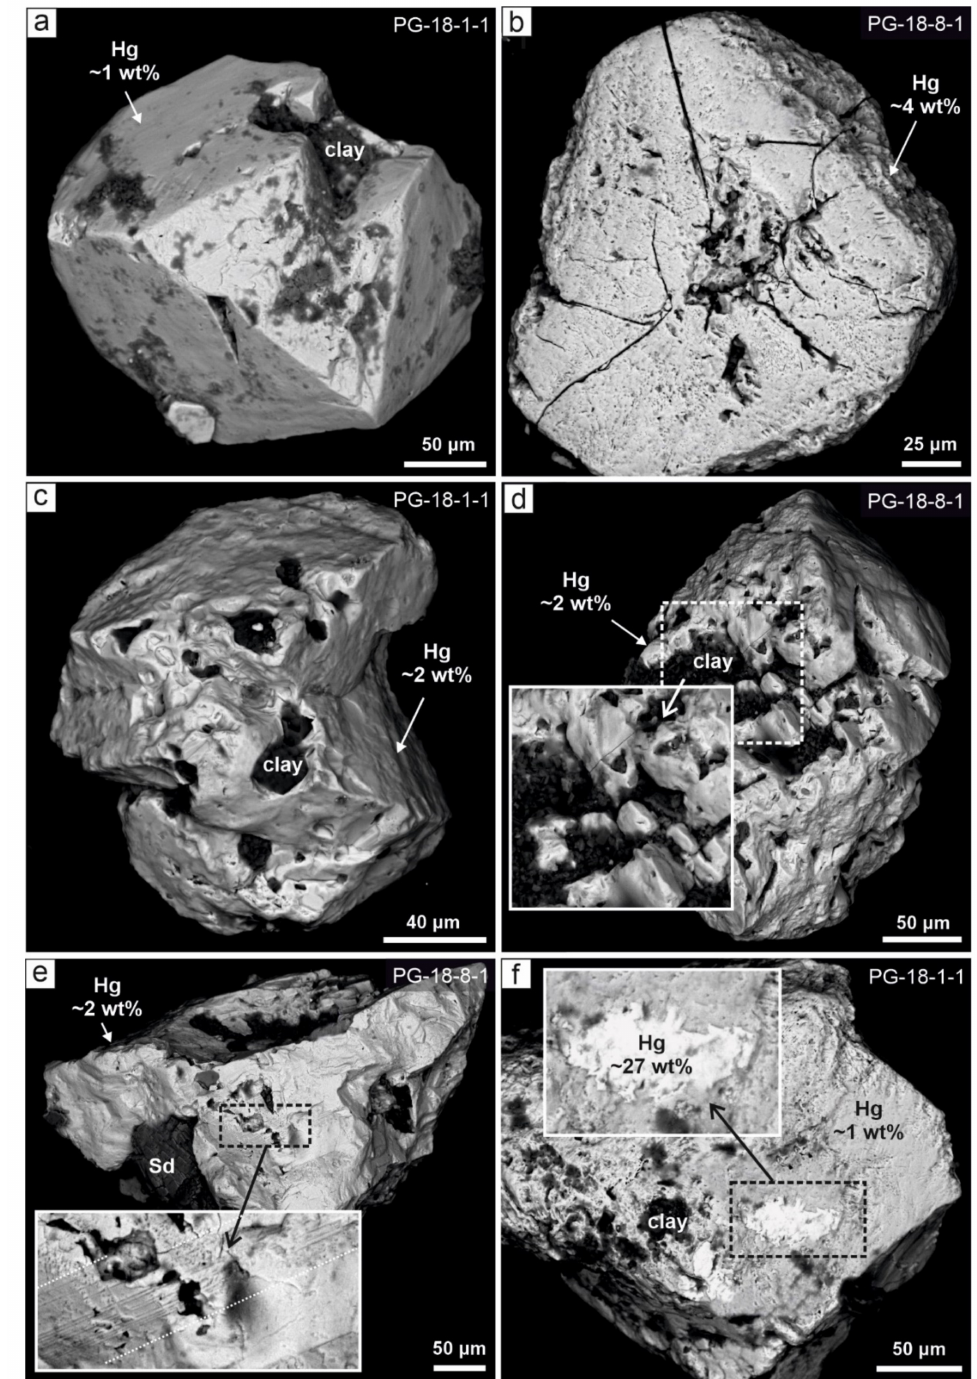
Figure 10. Morphology of medium-Hg and high-Hg sphalerites (1–27 wt% Hg) from mud masses of Pugachev MV, BSE images. ( a ) Tetrahedron with clayey matter inclusions. ( b ) Heavily etched rounded grain. ( c , d ) Sphalerite grains with smoothed edges and corners; its surface poisoned by clayey matter. ( e ) Intergrowth of siderite and sphalerite tetrahedron with a single set of polysynthetic twins. ( f ) Etched surface of sphalerite with high-Hg patches. Sd =